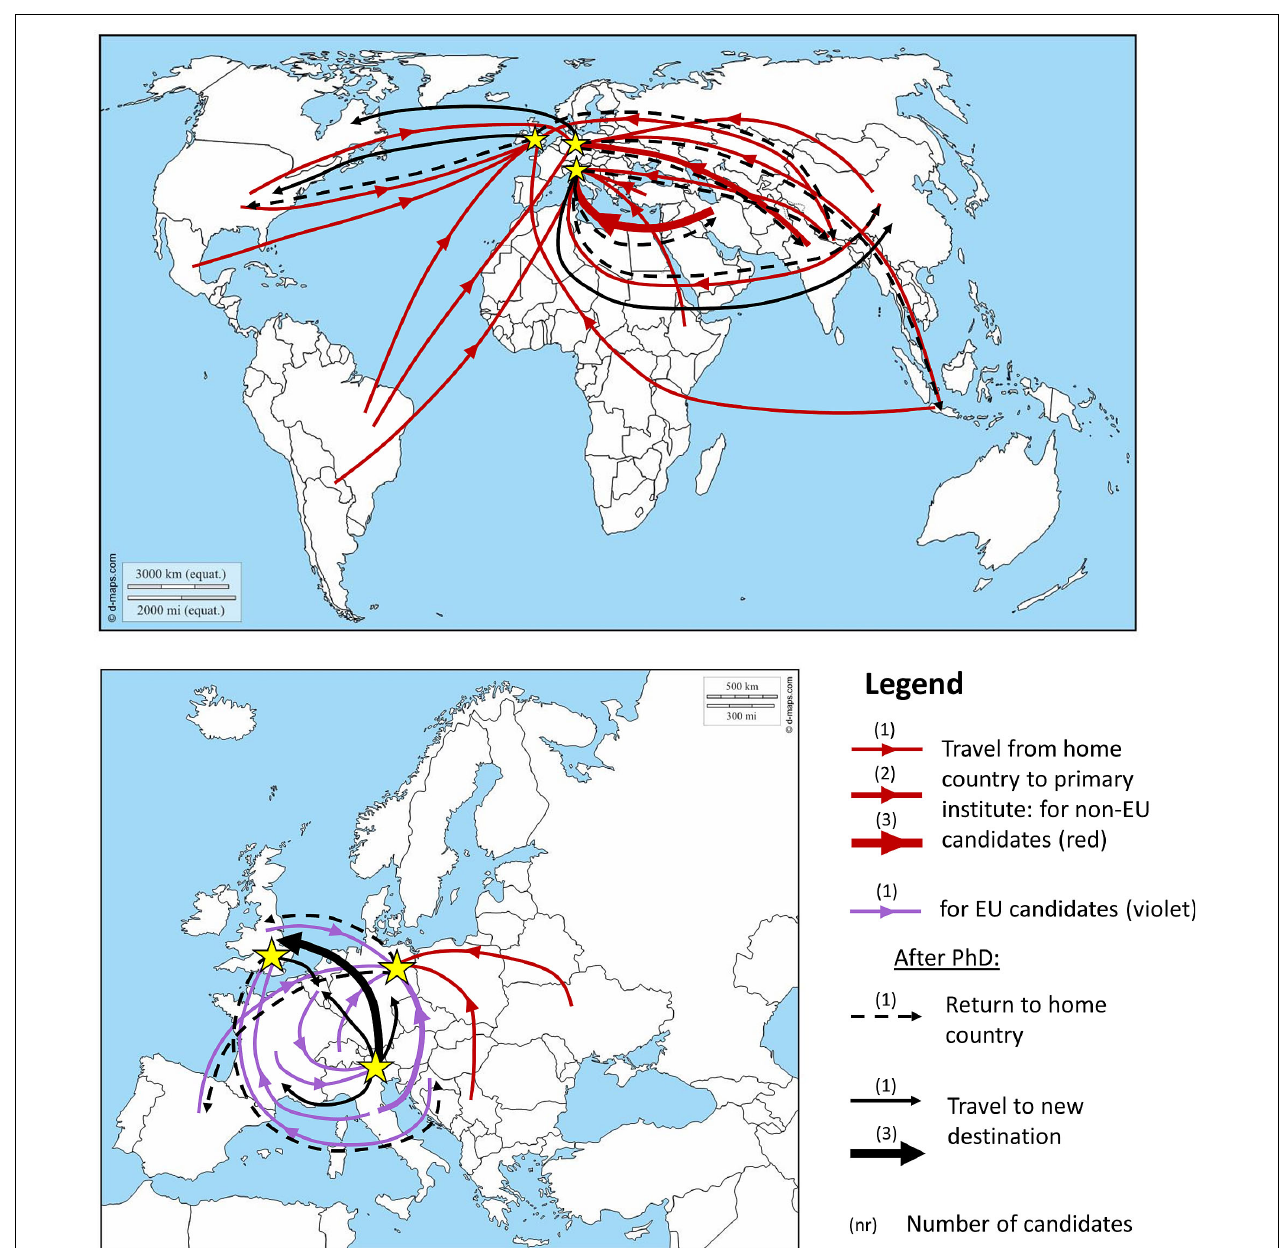
FIGURE 7 | Arrows indicate the movement of doctoral candidates from their home countries to the primary institutions at the start of the program (in red) and for those who did not stay in the same country their return to either their home country (black intermittent arrow) or to a new destination (black arrow). The upper panel shows a global map with travel between Europe and other continents, the lower panel presents a map of Europe with travel within